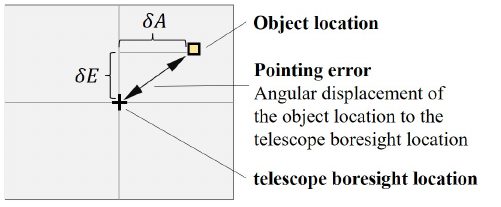
Figure 3. Definition of pointing